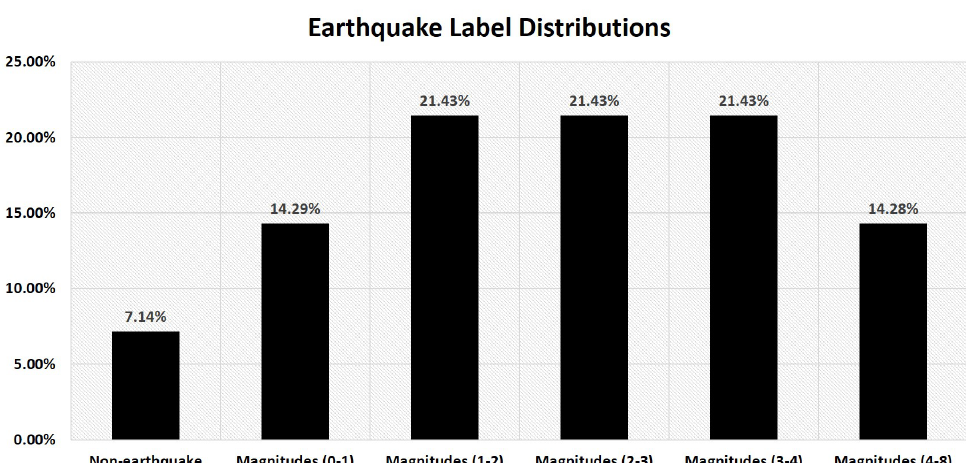
Figure 3. Label Distributions of Earthquake Magnitudes in Multi-label